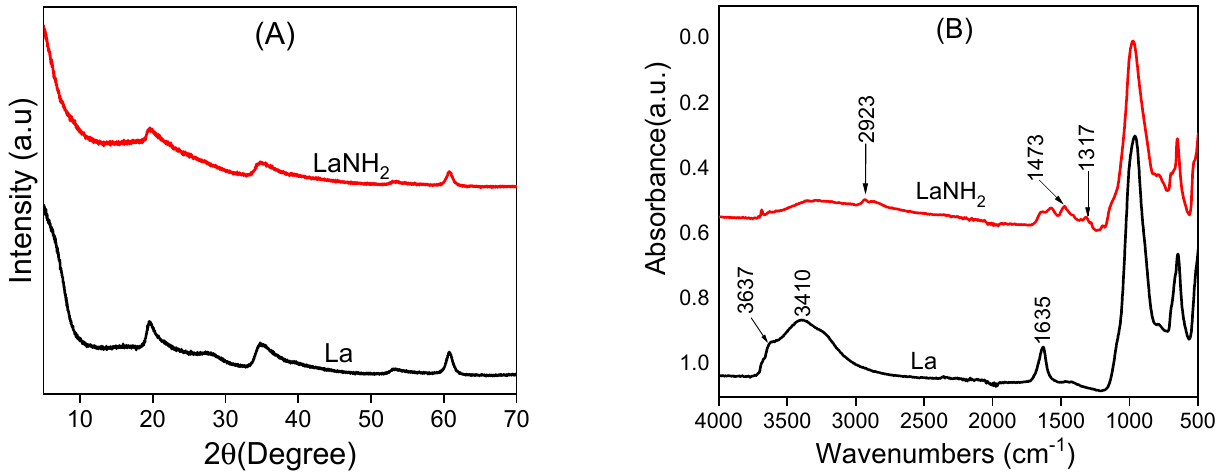
Figure 1. X-ray diffraction (XRD) patterns ( A ) and infrared spectra ( B ) of pristine laponite La and amino-functionalized laponite LaNH 2 materials.